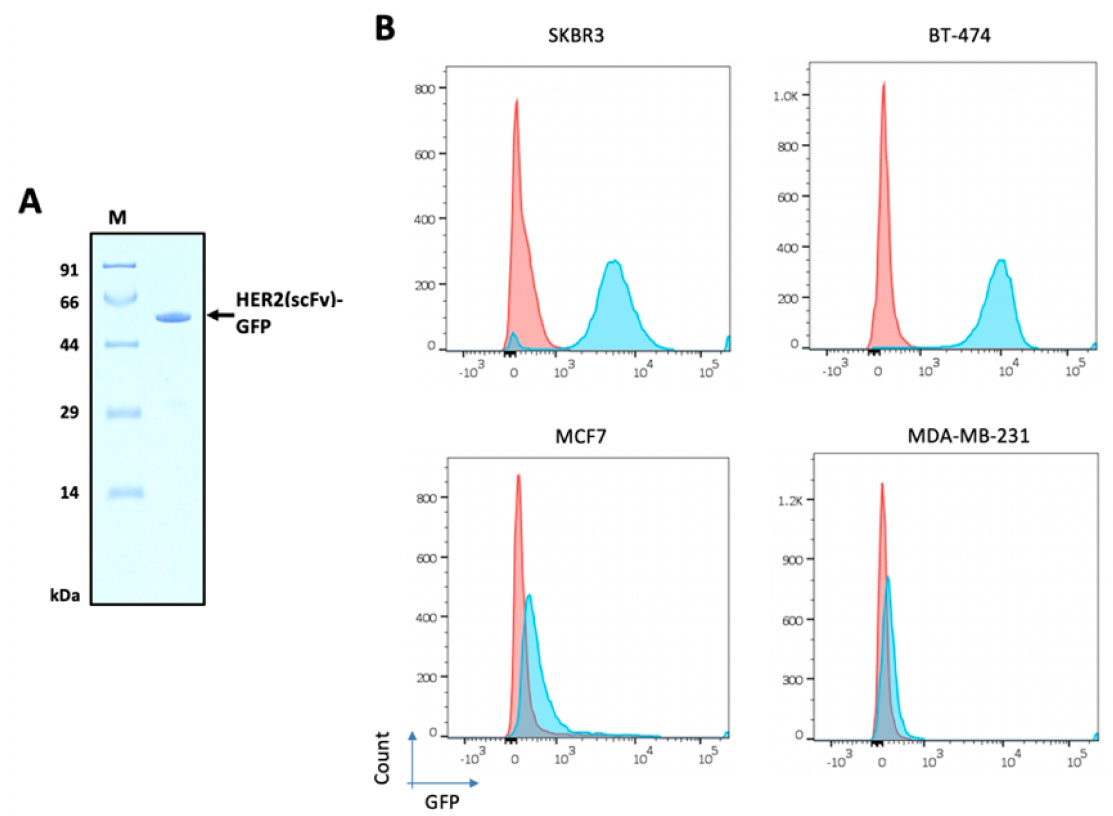
Figure 6. HER2 levels on the surface of four breast cancer cell lines. ( A ) Purified HER2(scFv)-GFP (54.4 kDa) from E. coli was used for FACS analysis. ( B ) SKBR3, BT-474, MDA-MB-231, and MCF7 cells were incubated with HER2(scFv)-GFP and stained with DAPI. Red represents cells not treated with HER2(scFv)-GFP and blue indicates cells treated with